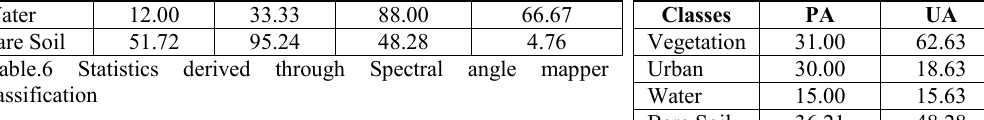
Table.6 Statistics derived through Spectral angle mapper classification